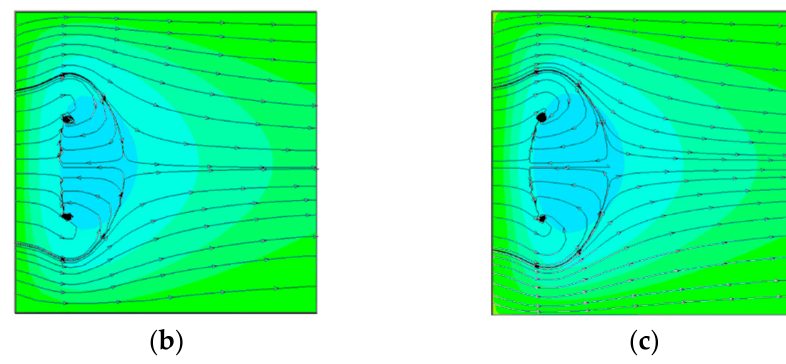
Figure 5. Stream lines at the top of the cube for three meshes: ( a ) coarse mesh; ( b ) basic mesh; ( c ) finer mesh.